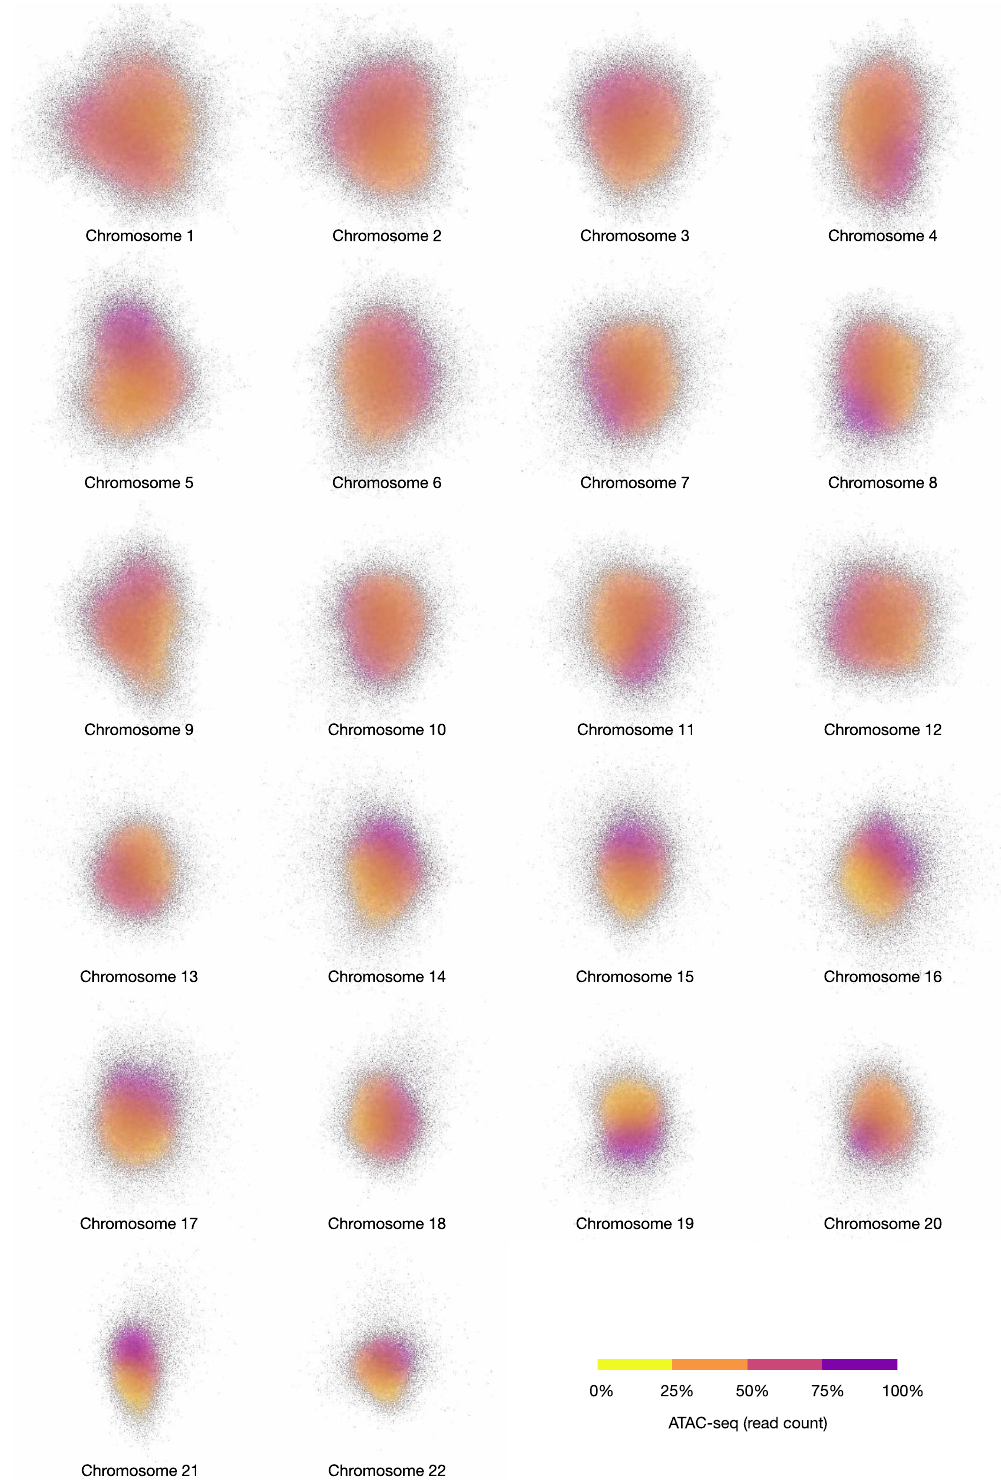
FIG. 15. An ensemble of 3D structures for all 23 chromosomes obtained from 1000 conformations that are aligned and superimposed for each chromosome. Each point represents one locus from one conformation. The colors encode the ATAC-seq signal